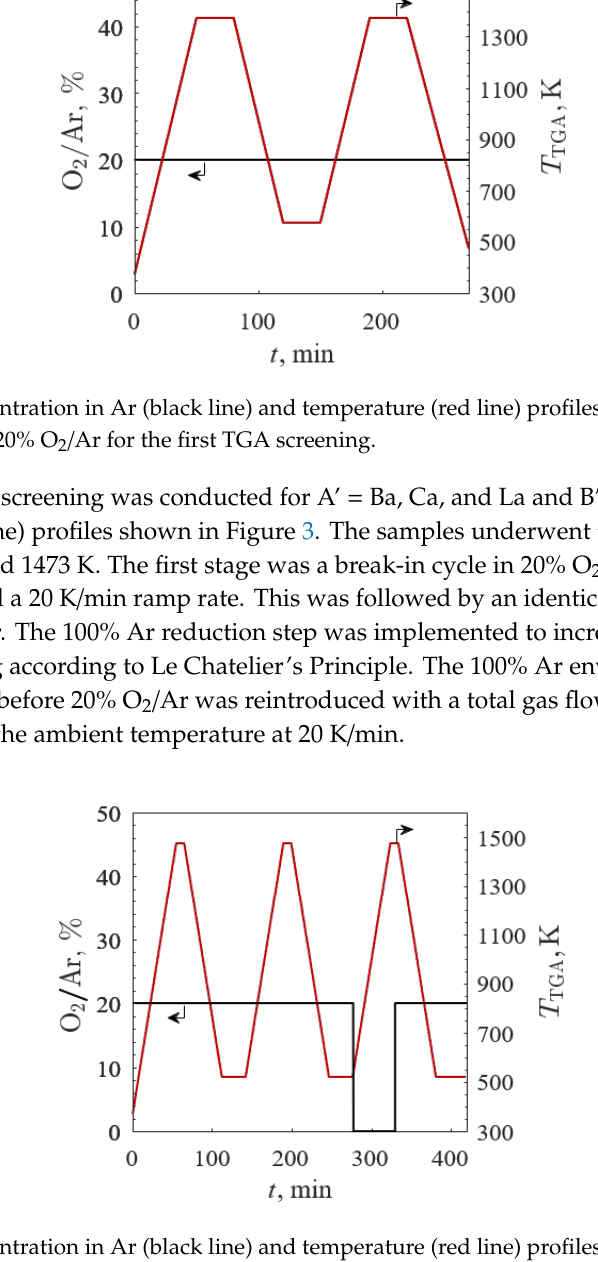
Figure 4. O 2 concentration in Ar (black line) and temperature (red line) profiles versus time with the ( a ) temperature-swing between 523 and 1473 K in 20% O 2 /Ar and ( b ) O 2 pressure-swing between 20% O 2 /Ar and 100% Ar at 1023 K for the third TGA screening. 3. Results A’ x Sr 1− x B’ y Fe 1− y O 3−δ with 0 ≤ x,y ≤ 0.2 was synthesized. Synthesis was limited to x and y ≤ 0.2 to study incremental changes in the SrFeO 3 structure. Higher x and y did not always result in single phase perovskite oxides and were not examined further. Ba 2+ and Ca 2+ were selected as A-site substituents based on similar ionic radii to Sr 2+ (ionic radii of 135, 100, and 118 pm, respectively [23]). La 3+ (ionic radii of 103 pm [23]) was selected as an A-site substituent to examine the impact of increasing average A-site charge while decreasing average B-site charge. First-row transition metals with multiple oxidation states (e.g., Co, Cr, Cu, and Mn) were selected for B-site substitution due to strong favorability for forming stable perovskite oxides as predicted from density functional theory modeling [24]. The standard first letter convention for perovskite oxides, followed by the site fractions (e.g., Ba 0.2 Sr 0.8 FeO 3−δ ≡ BSF280 and SrCo 0.1 Fe 0.9 O 3−δ ≡ SCF019), was used in this work to identify different A’ x Sr 1− x B’ y Fe 1− y O 3−δ . The convention was adjusted to include the full elemental symbols for Ca, Cr, and Cu with C representing Co. 3.1. Characterization XRD was used to determine the crystal structures of A’ x Sr 1− x B’ y Fe 1− y O 3−δ . The diffractograms are shown in Figure 5 for SCoF019 (top blue), LSF190 (middle red), and LSF280 (bottom yellow) compared with SrFeO 3−δ (vertical dashed lines). Single-phase tetragonal or cubic perovskites with peaks similar to cubic SrFeO 3−δ were observed, except for LSF190, which shows a peak at 2θ = 32.3°